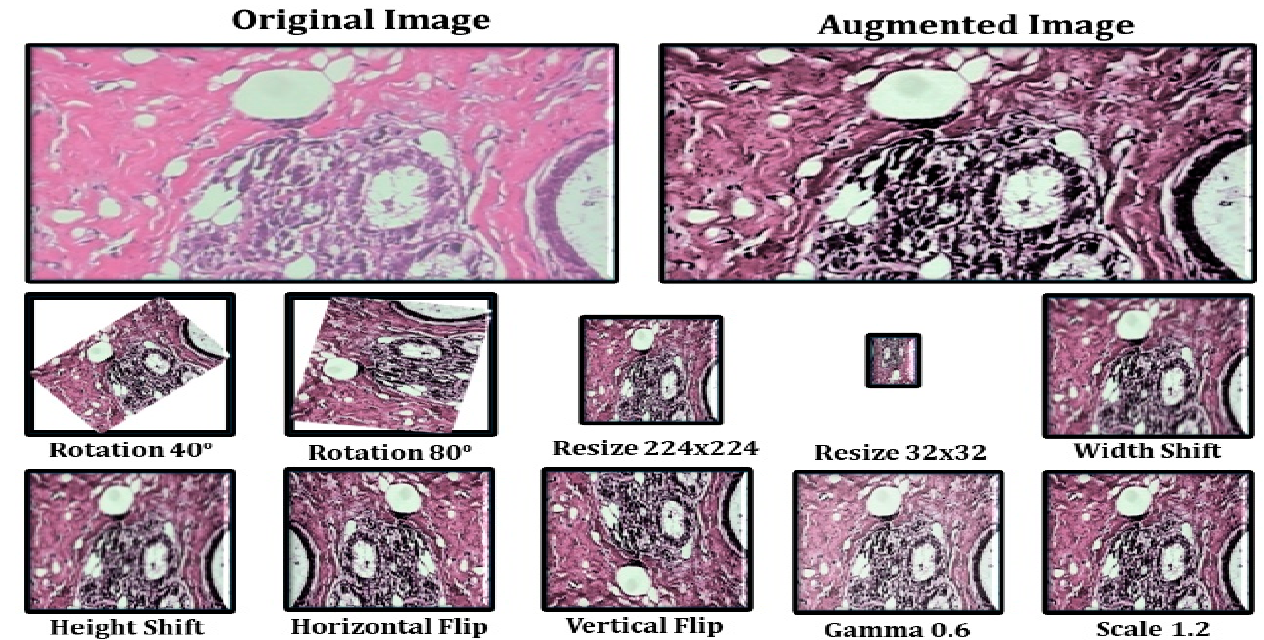
Figure 5. Data Augmentation Results.